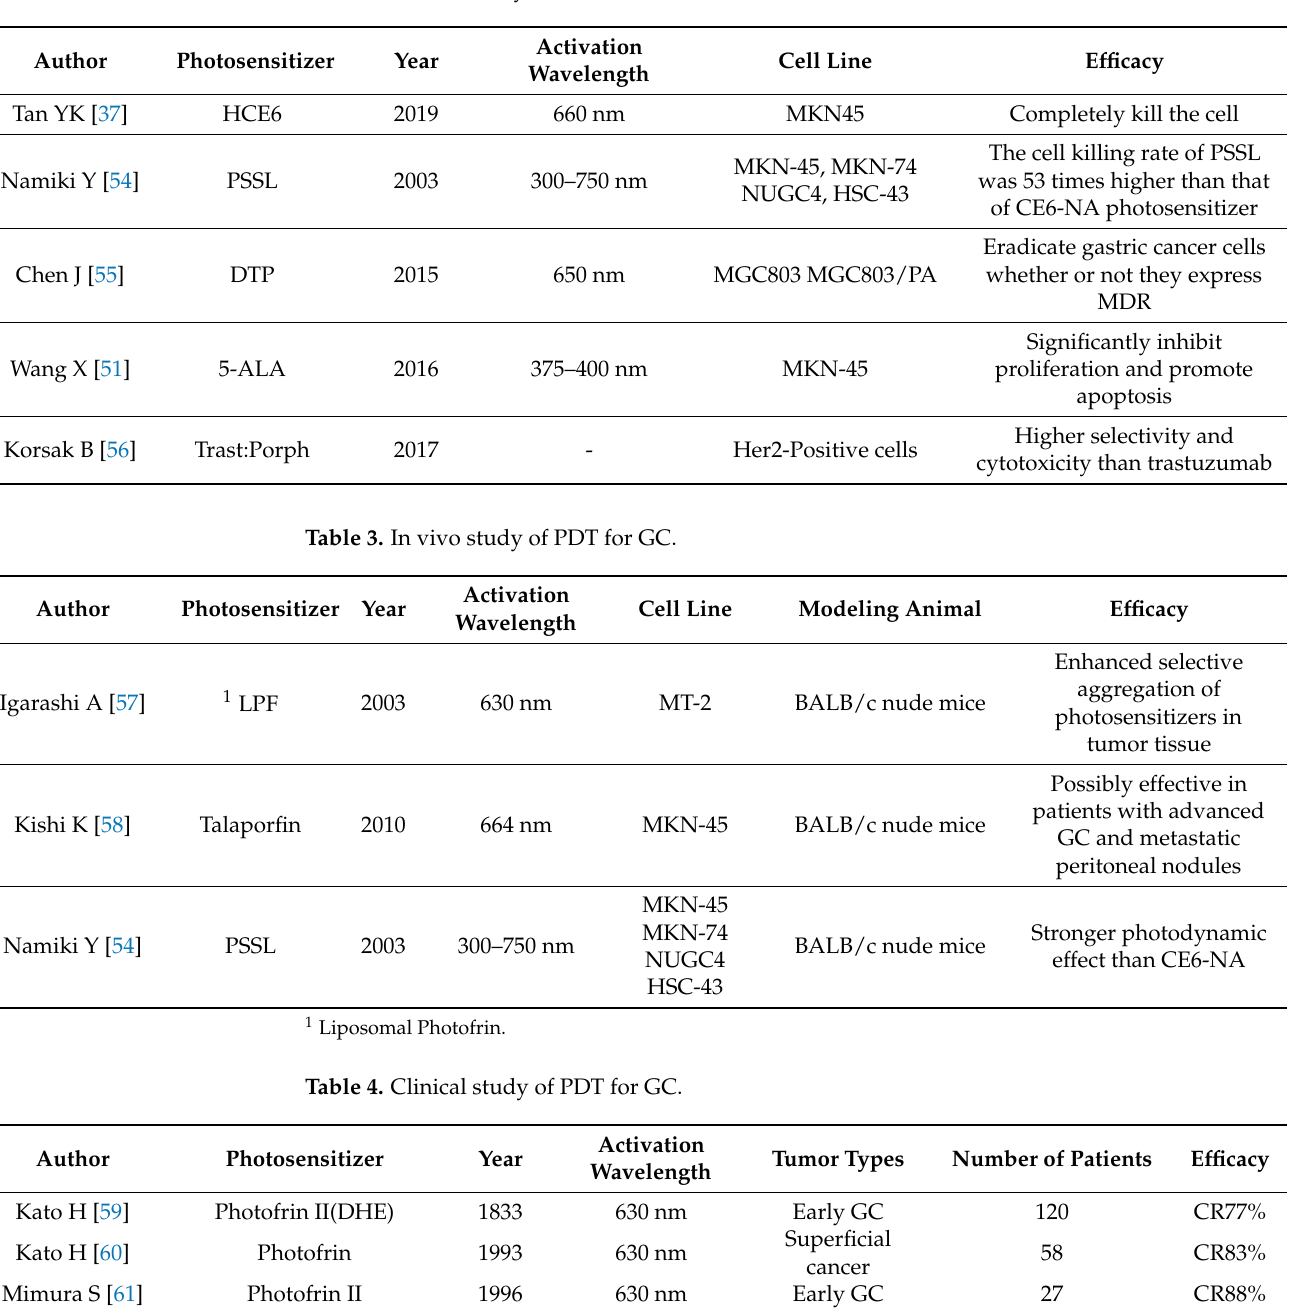
Table 2. In vitro study of PDT for GC.